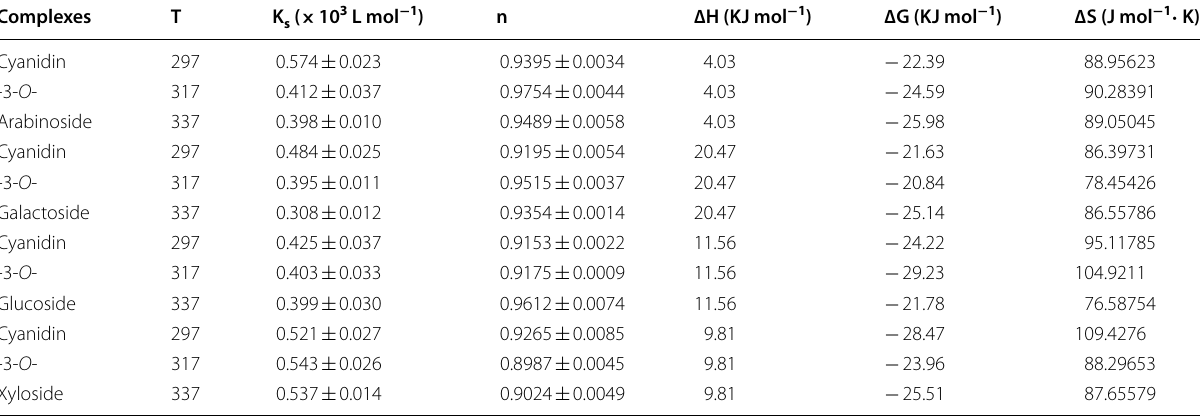
Table 2 The binding constants and thermodynamic parameters of Cyanidin-3- O -arabinoside, Cyanidin-3- O -galactoside, Cyanidin-3- O -glucoside and Cyanidin-3- O -Xyloside at 297, 317 and 337